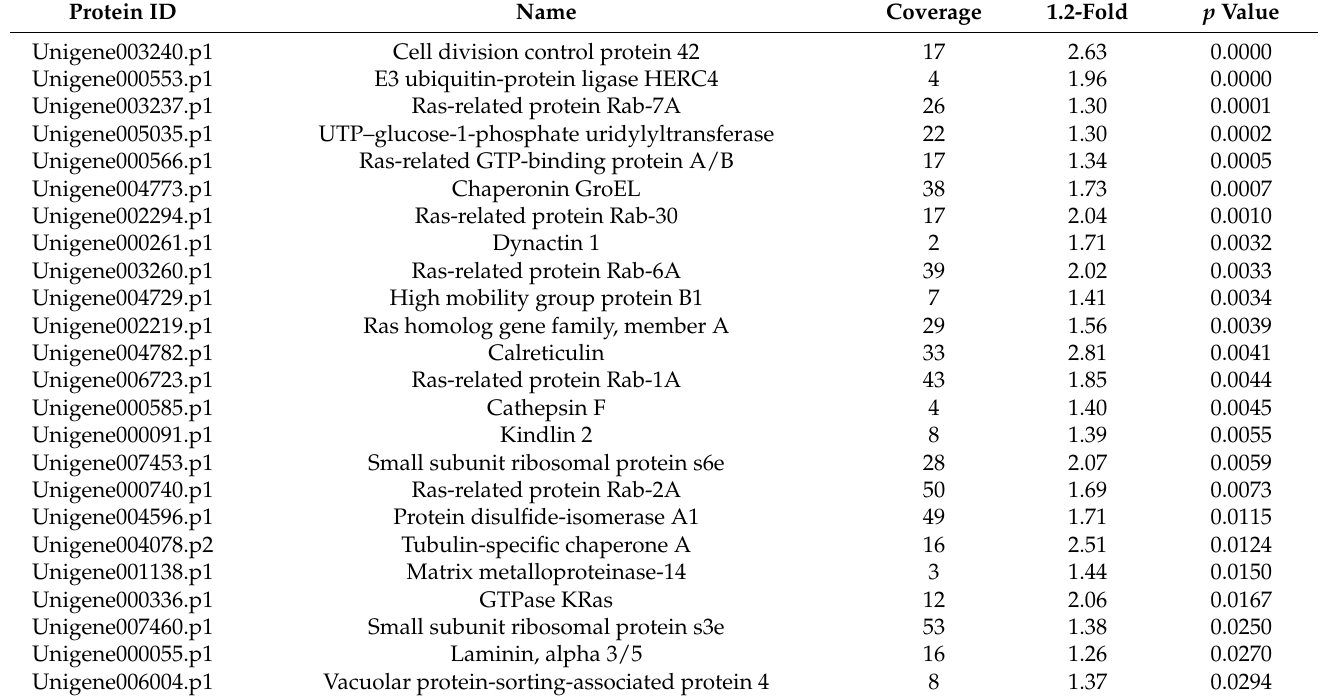
Table 2. Representative differentially expressed proteins related to the innate immune system in the Chinese mitten crab, with a 1.2-fold change, with P. gregaria infection. Protein